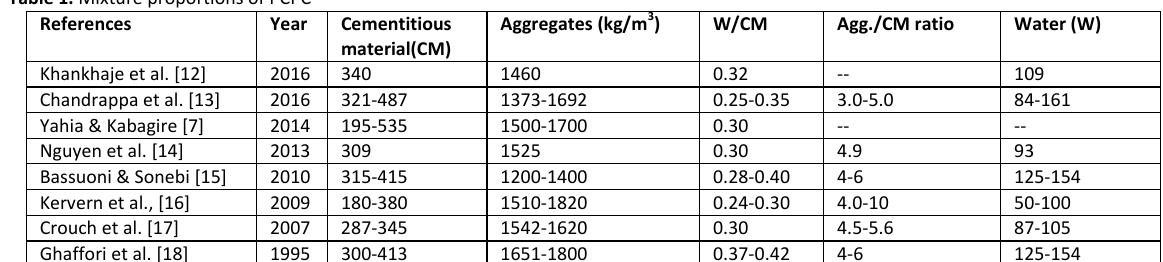
Table 1. Mixture proportions of PCPC